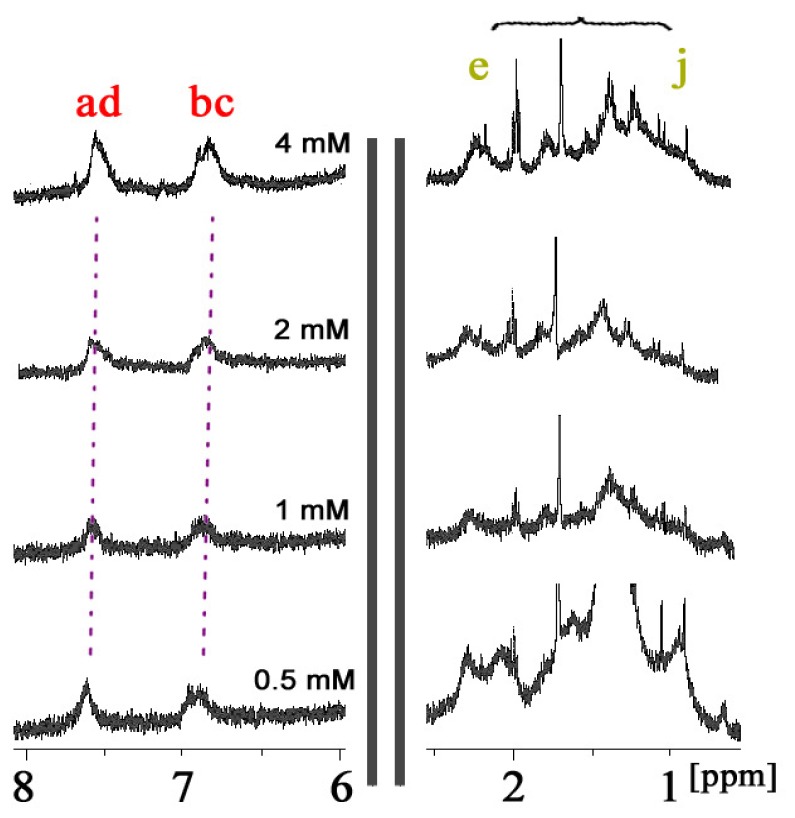
1H NMR spectra of CDAS in D2O at 298 K at different concentrations.